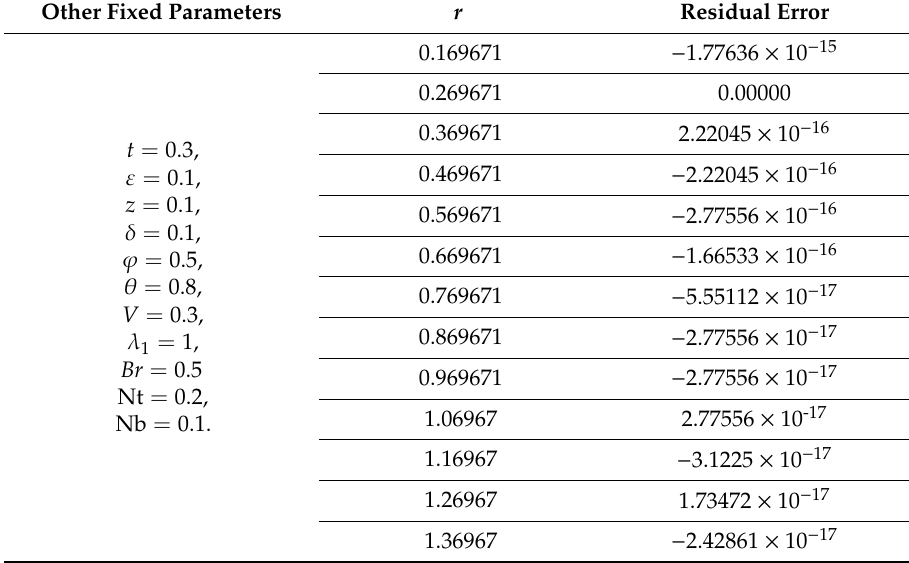
Table 2. Error variation of temperature solution θ when other parameters are